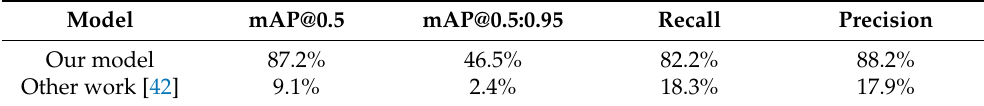
Table 5. Comparison with other work completed with YOLOv5.